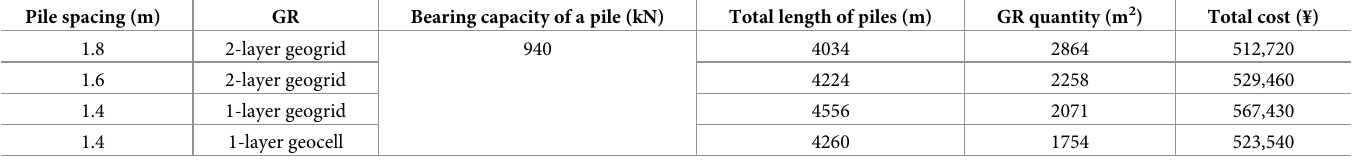
Table 9. Comparison of the pile quantities and costs for various embankment specifications. Pile spacing